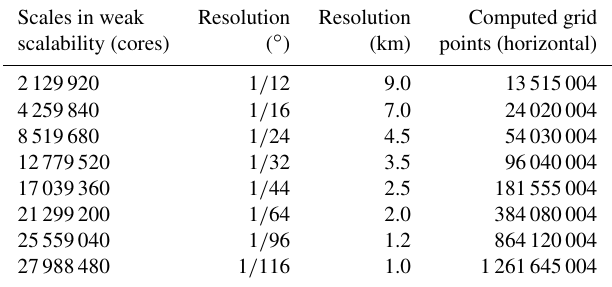
Table 3. Eight different scales used in weak scalability, with the conversion between resolution in degrees and resolution in kilome- ters. The total number of computed grid points used in weak scala- bility is also